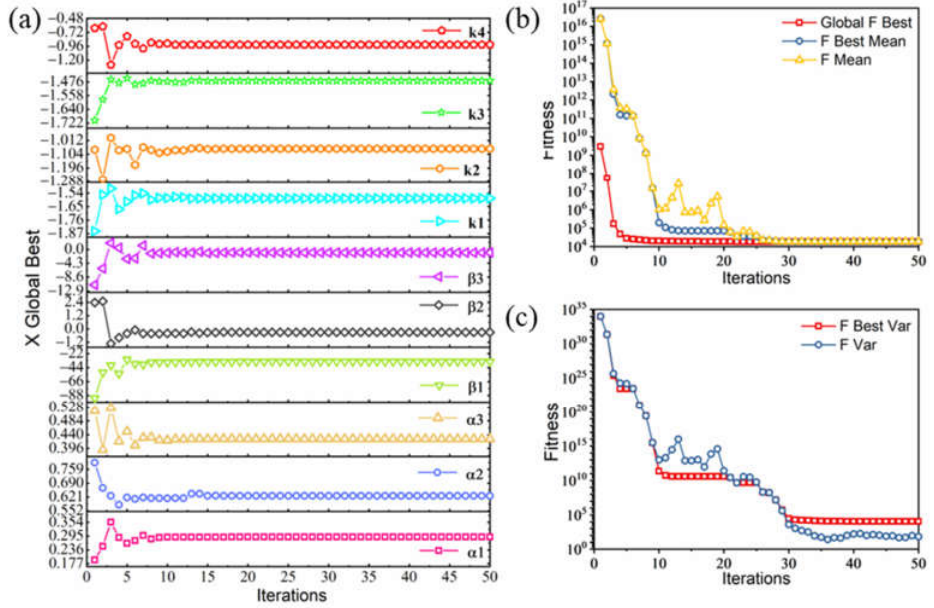
Table 3. Secondary particle search range of transmission system.